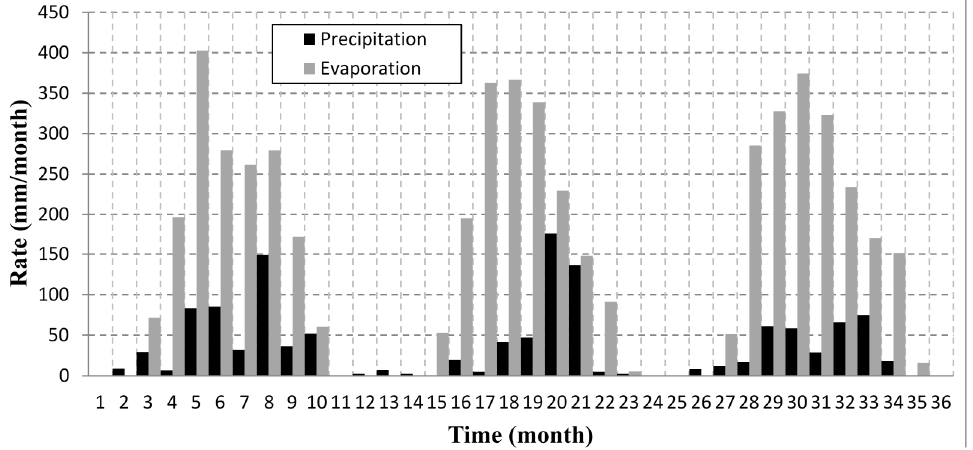
Figure 4. Precipitation (measured by rain gauge) and evaporation (measured by evaporation pan with a diameter of 20 cm) rates for 36 stress